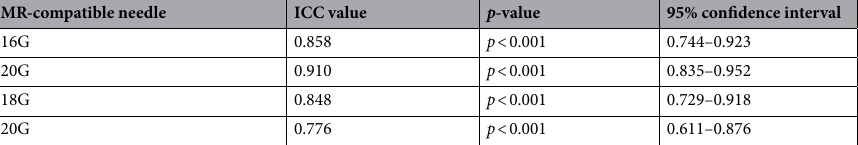
MR-compatible needle ICC value p